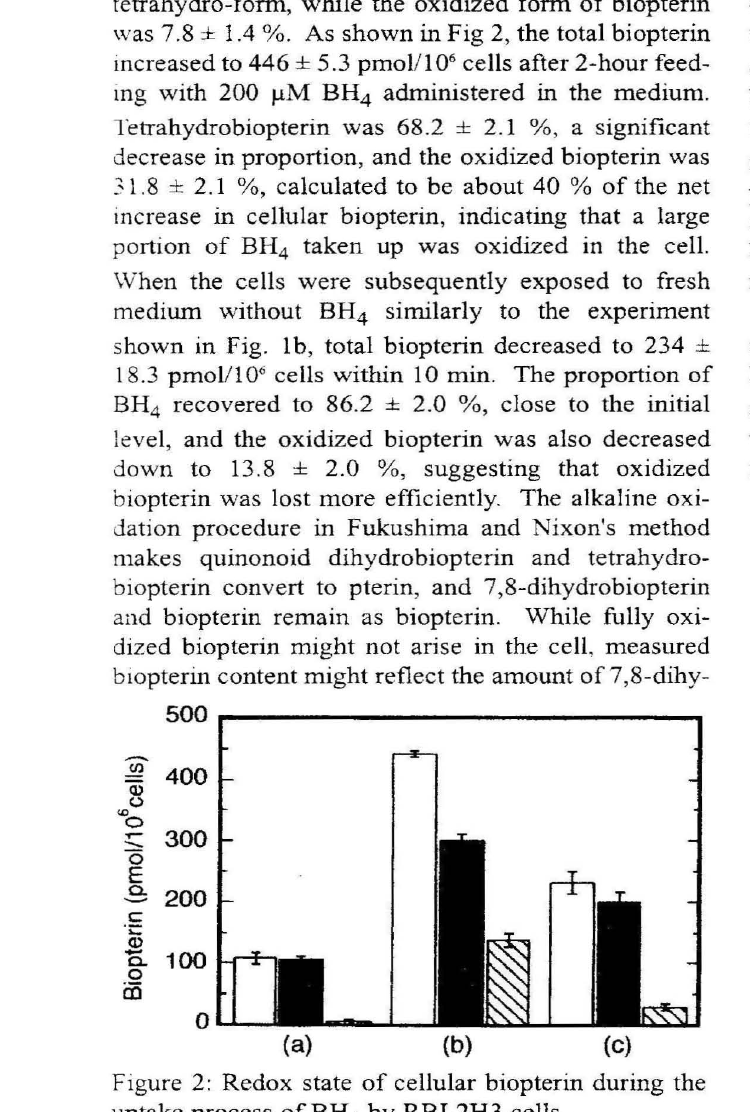
Figure 2: Redox state of cellular biopterin during the uptake process ofBH4 by RBL2H3 cells.